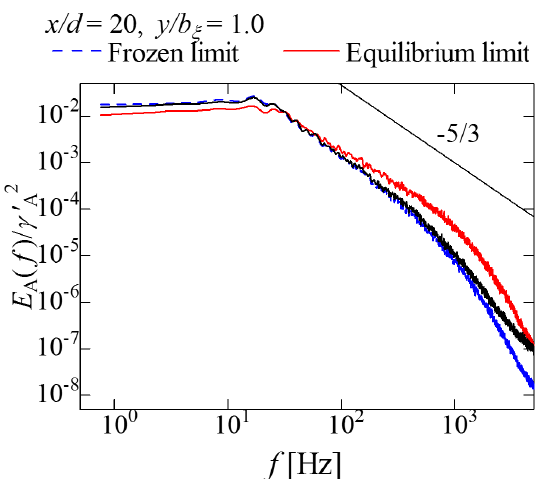
Fig. 15 The normalized power spectrum of concentration fluctuations of reactant A, E A ( f ) =(cid:13) A ′ 2 for Da = 11 : 7, obtained by the new system at x = d = 20 and y= b (cid:24) = 1 : 0 (black line). The power spectra of concentration fluctuations in the frozen limit (blue dashed line) and the equilibrium limit (red line) are shown